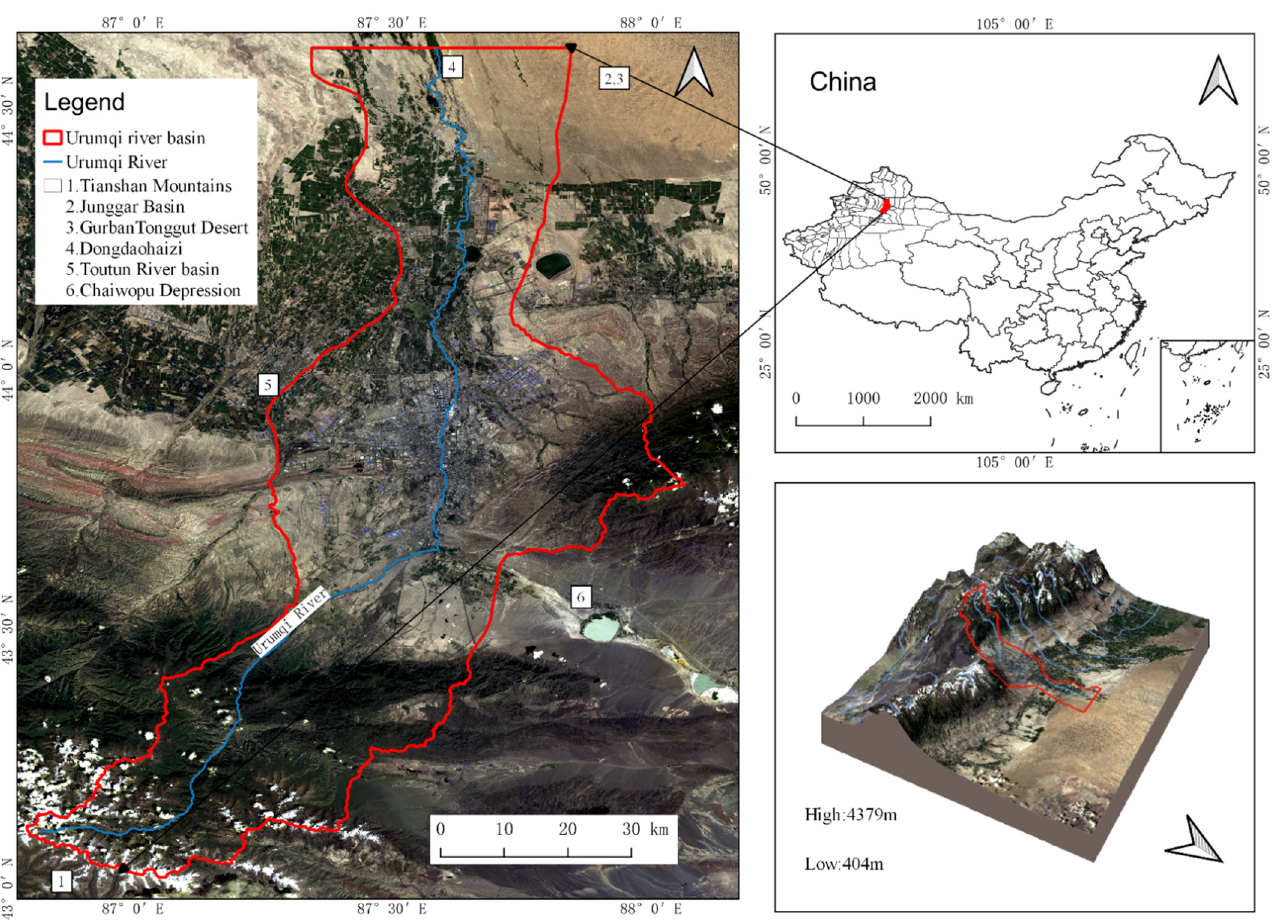
Figure 1. Location of the Urumqi River basin. The vegetation of the basin belongs to 12 families and 35 species